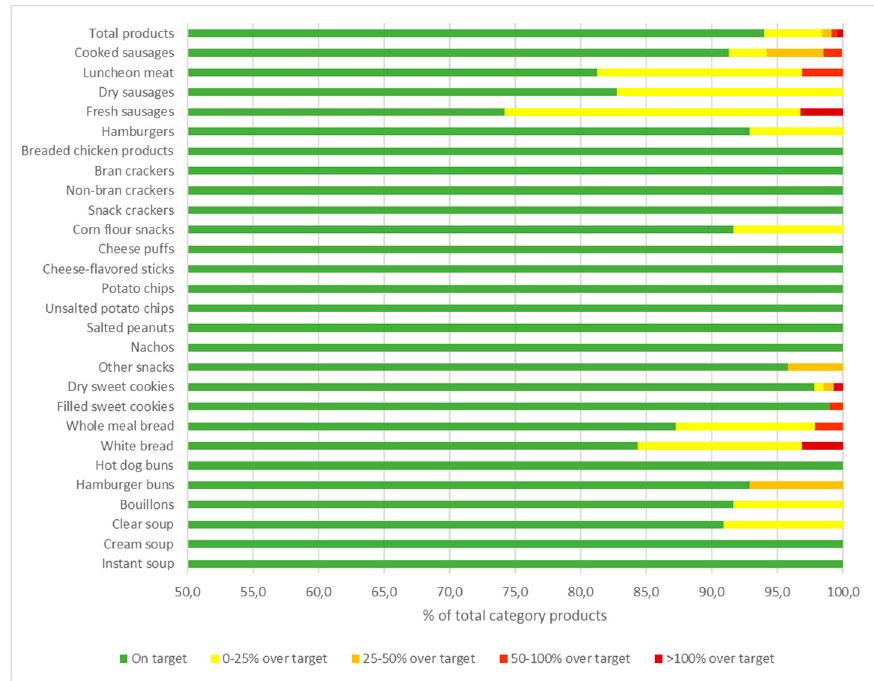
Figure 2. Food product categories compared with the National Act 26,905 maximum sodium levels. In green, % of products with a sodium content below the allowed maximum sodium level. In yellow, orange, red, and dark red, % of products with a sodium content above the allowed sodium level by 0–25%, 25–50%, 50–100%, or more (n = 864).